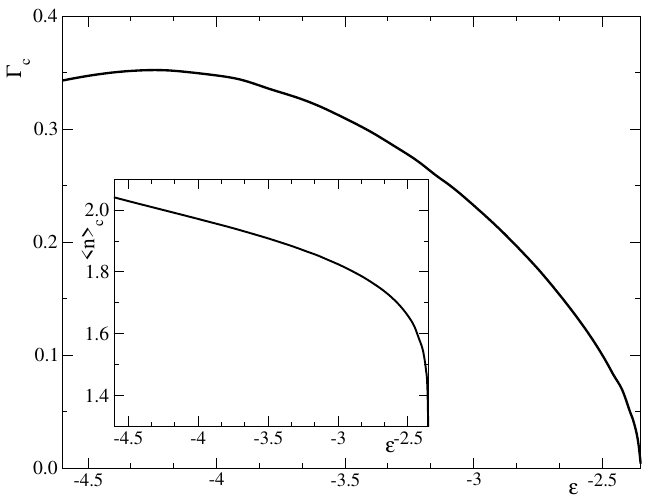
Figure 2: Phase diagram of the Anderson model in the ε , Γ plane for U = 3.5, U ′ = 2.5 = 0.5. Below (above) the curve the phase is a NLFL (usual Fermi liquid). and J H Inset: occupancy of the Ni at the